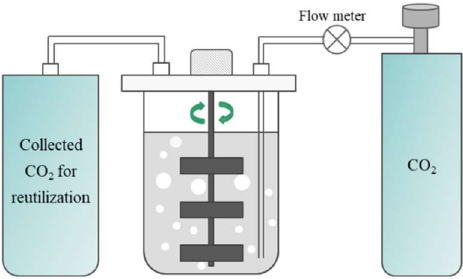
Figure 4. The chemical reaction between CMFB slurry and CO 2 is carried out under stirring.